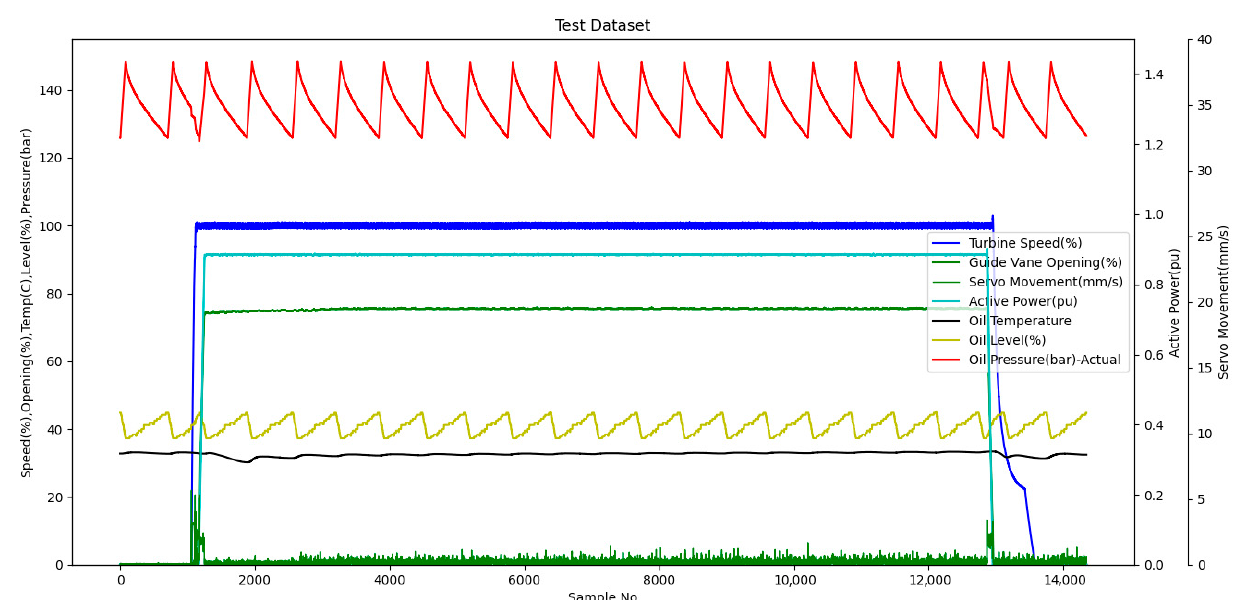
Figure 17. Test dataset without pump status.